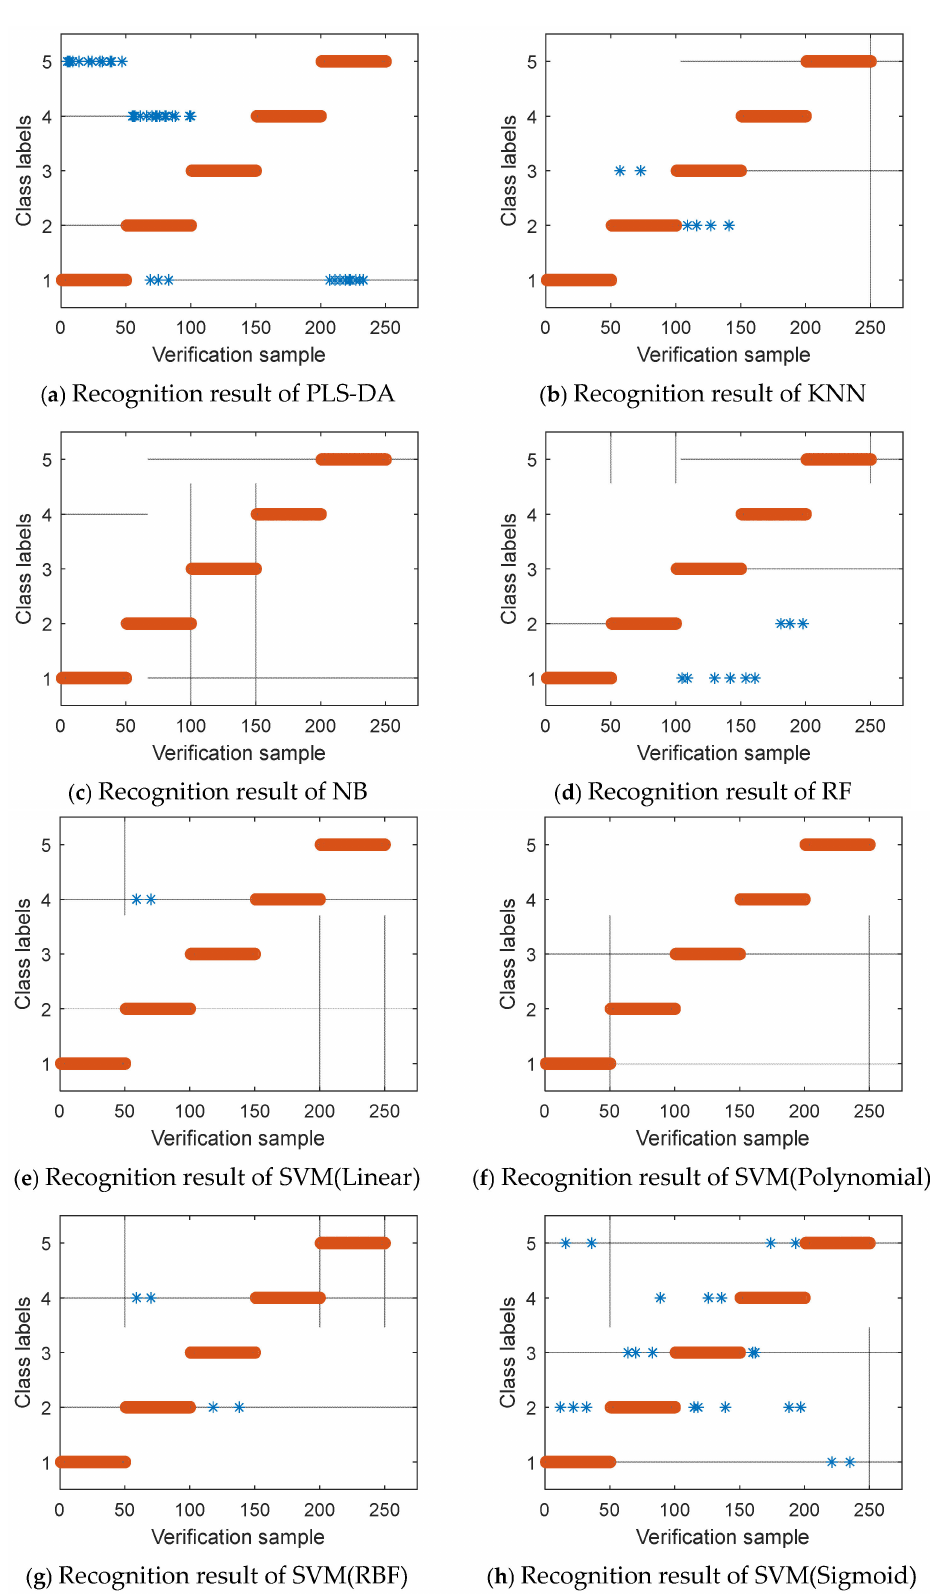
Figure 6. The recognition results of diffident models based on full-spectrum. The red mark (o) indicates the actual category of corn kernels, the blue mark (*) indicates the predicted category of corn